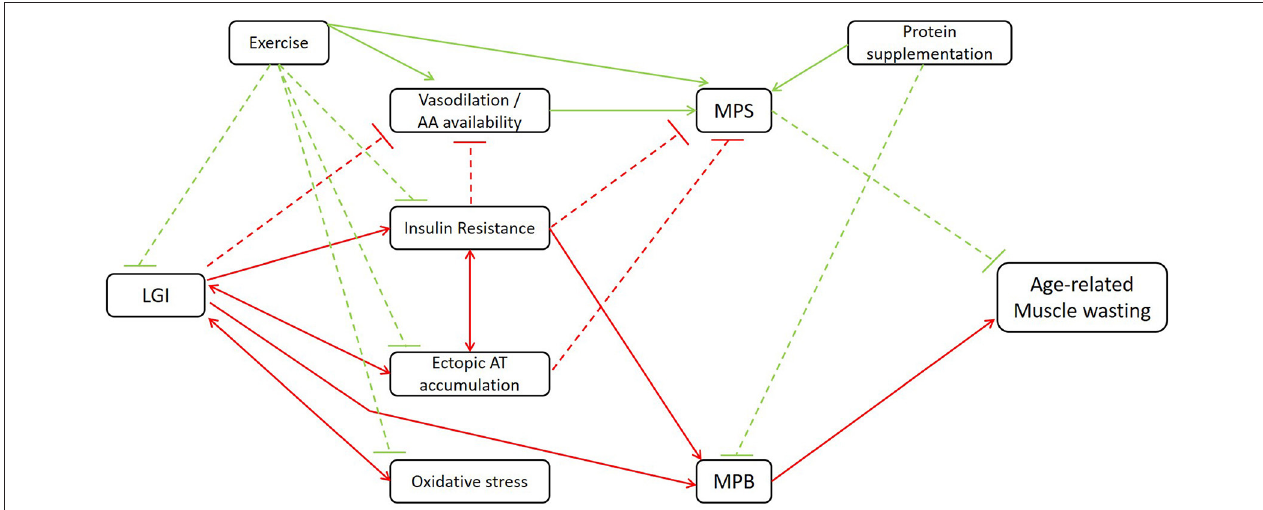
FIGURE 1 | Schematic illustration of the mechanisms through which LGI may indirectly affect age-related muscle wasting. LGI, low-grade inflammation; AA, amino acid; AT, adipose tissue; MPS, muscle protein synthesis, MPB, muscle protein breakdown. Red lines contribute to the induction of muscle wasting; green lines to the attenuation of muscle wasting. Dashed lines: inhibitory signaling; full lines: stimulatory signaling. Additional to the association between LGI and age-related muscle wasting, the beneficial effects of classic strategies such as exercise and protein supplementation are